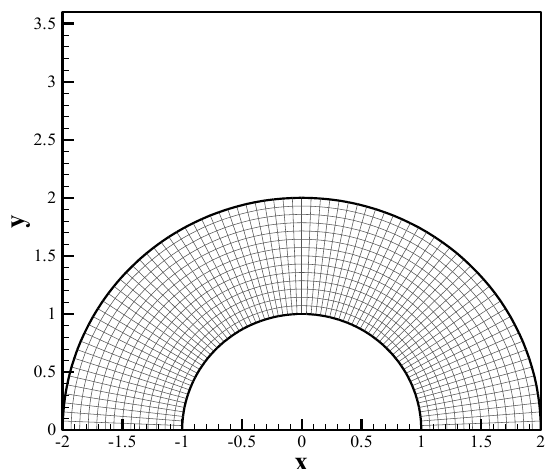
Figure 6. The grid generated in the area enclosed by two semicircles using the compact method.